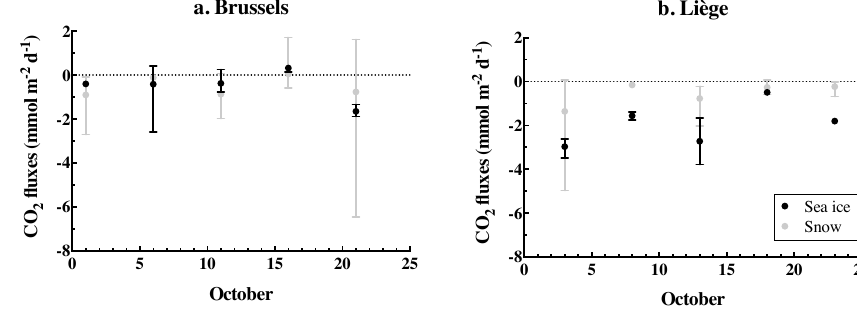
Figure 8. CO 2 fluxes (in mmolm − 2 d − 1 ) measured over sea ice and snow for the Brussels and Liège